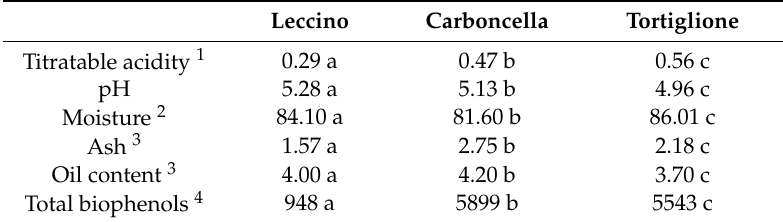
Table 1. Chemical characteristics of DMF fresh p â t é . Significant di ff erences are indicated by di ff erent letters at p < 0.05 ( t